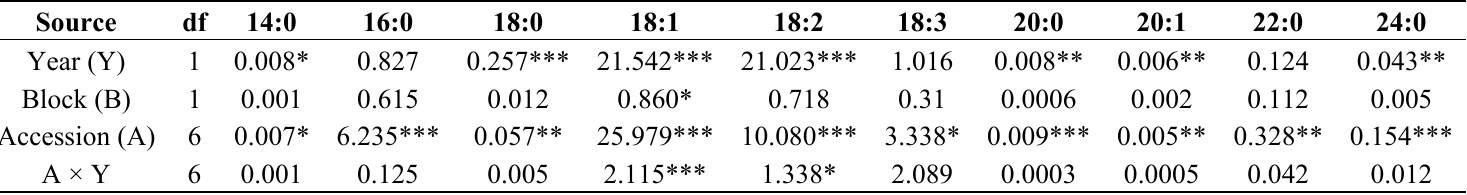
Table 1. Mean squares from analysis of variance of fatty acids (%) in horse gram seeds harvested from seven accessions (A) grown in two years (Y).